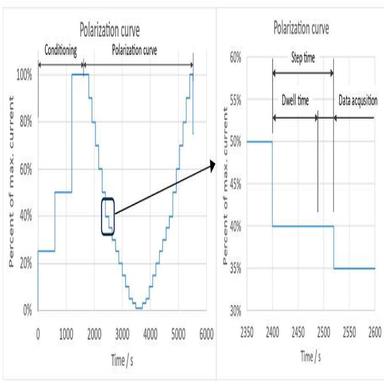
Left: Detailed view of one step and the naming of different times (own display).